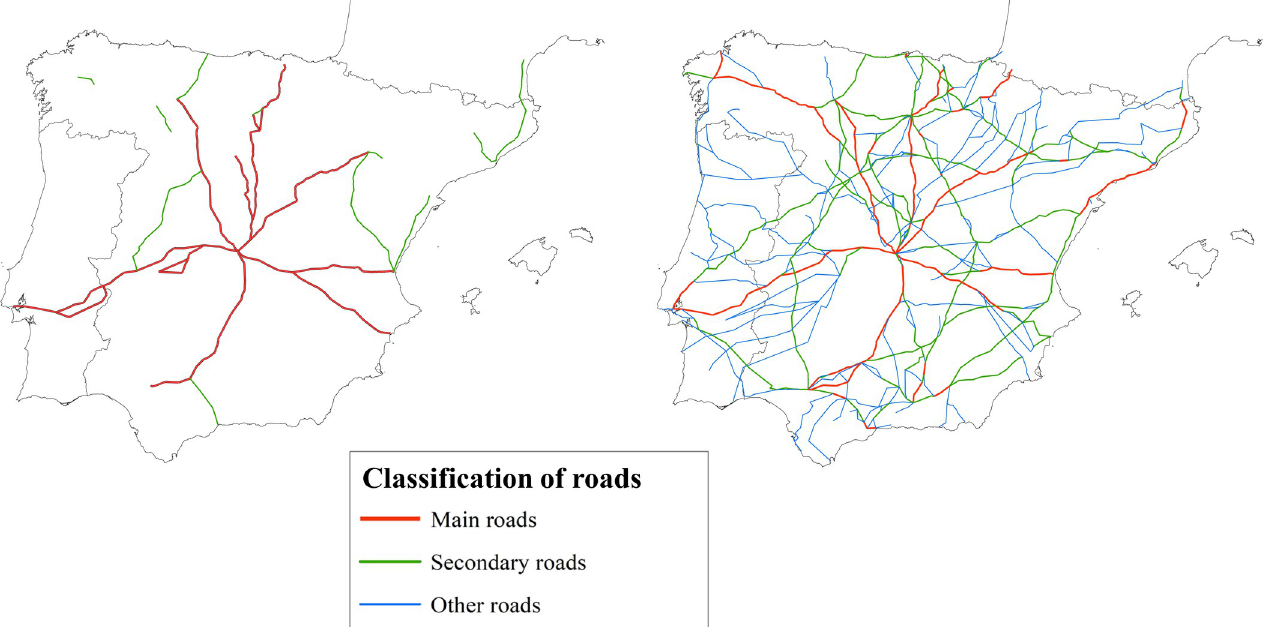
Fig 9. Radial structure of the road network in the late sixteenth/early seventeenth centuries. Notes: The categorization of the 1600 road network (right) was done by aggregating information from the three available sources for the period suggesting the methodology proposed by Mene´ndez Pidal [18] and Braudel [149]. In red are the main sections of road that appear in the three sources, in green are the secondary roads that appear in two, and blue are the less important roads that appear in a single source. Source : Produced by the authors from Hogenberg [112], Andree [150], Eichoviothias [151], and de Mayerne [152]. Base map from the Centro Nacional de Informacio´n Geogra´fica